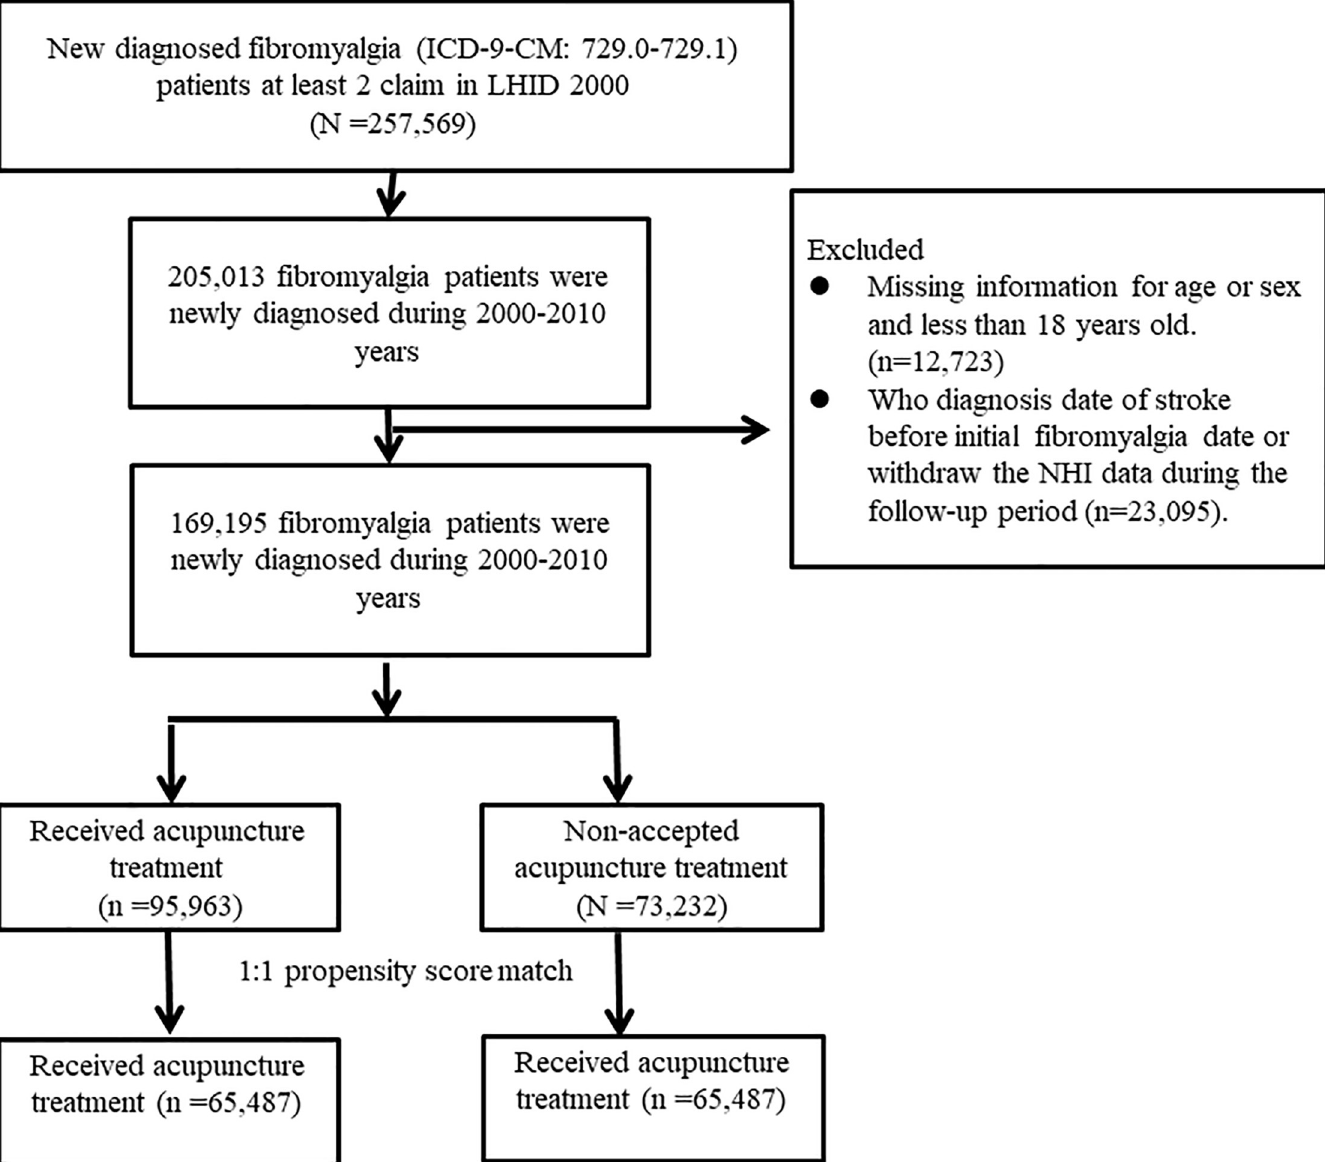
Fig 1. Study population flowchart. We identified 169,195 patients who were newly diagnosed with fibromyalgia between 2000 and 2010. After 1:1 propensity score matching by sex, age, comorbidities, drug use, diagnostic year and index year was performed, the acupuncture cohort and non-acupuncture cohort both comprised 65,487